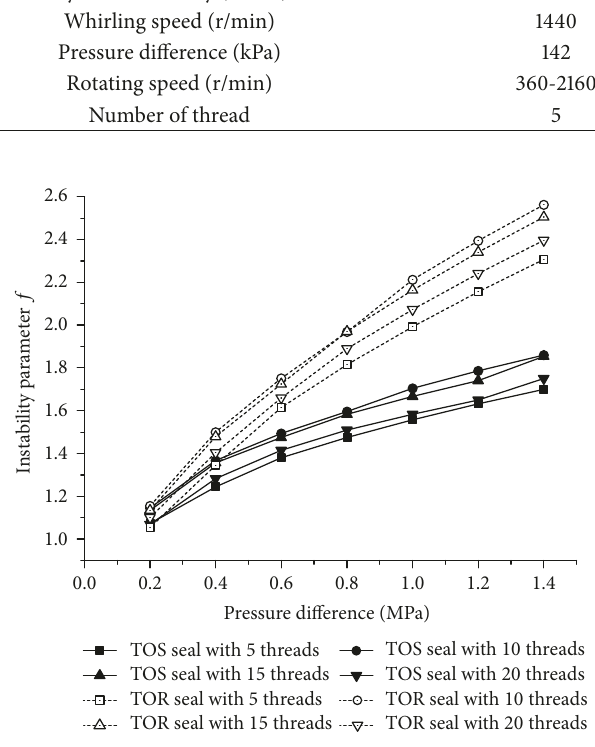
Figure 8: Instability parameter 𝑓 of herringbone-grooved TOR and TOS seals under different pressure